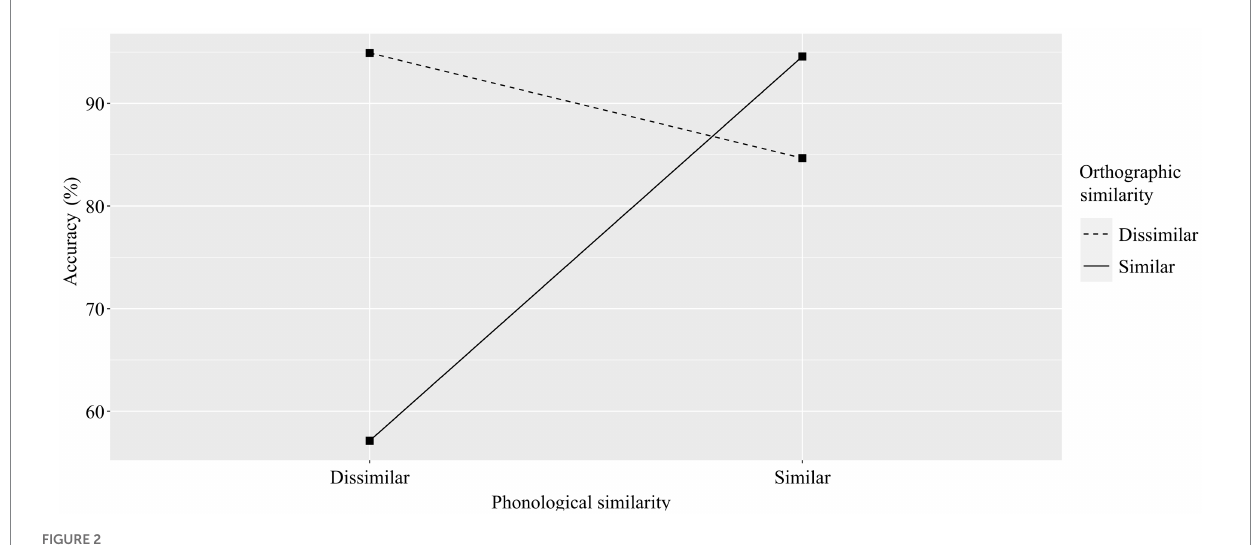
FIGURE 2 Effects of phonological and orthographic similarity on accuracy (%).